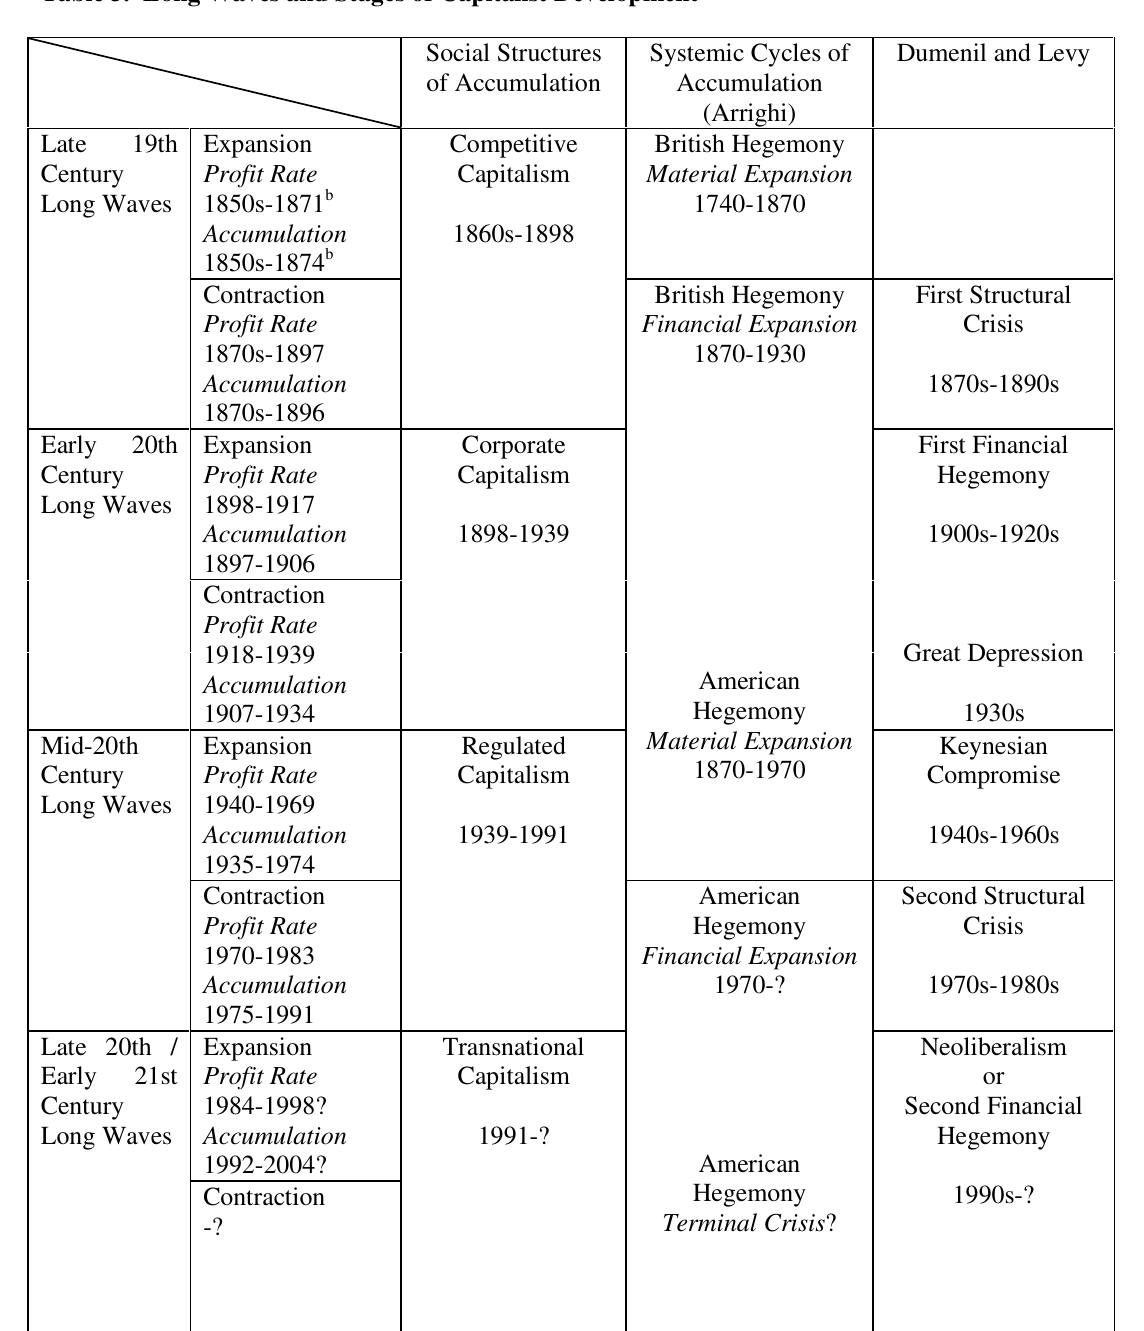
Table 3. Long Waves and Stages of Capitalist Development